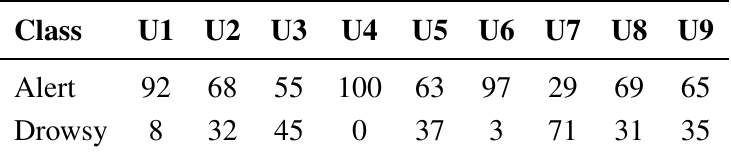
Table 3. Percentage of samples in each class per driver